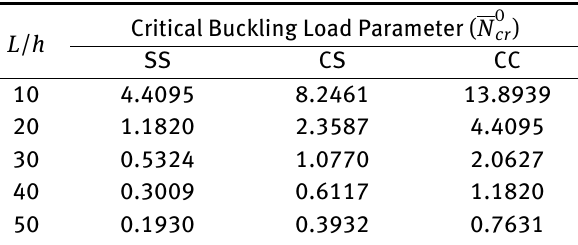
Table 6: Critical buckling load Parameter for various